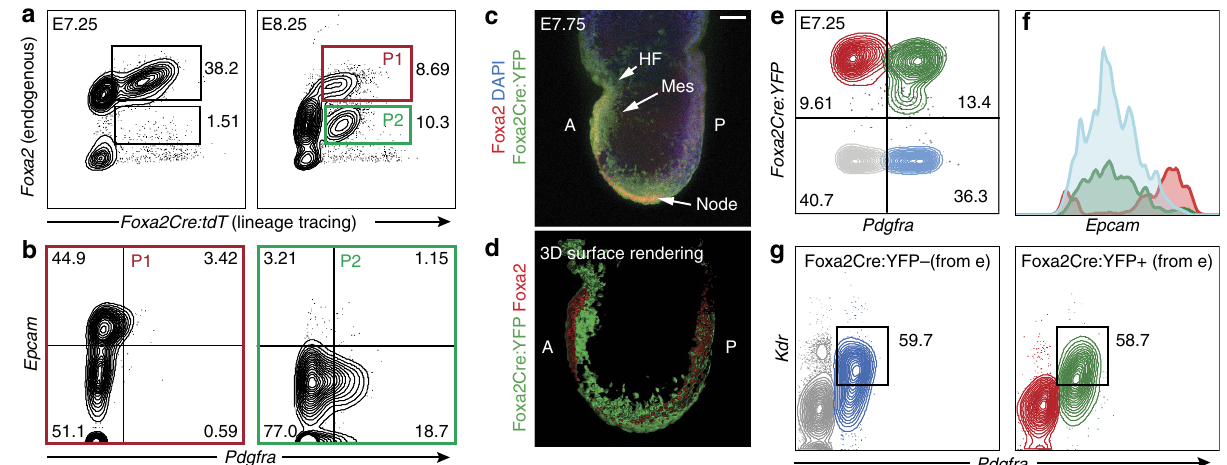
Figure 2 | Foxa2 expression marks a transient progenitor population during gastrulation that gives rise to CM. ( a ) Flow cytometry analysis of dissociated E7.25 (left) or E8.25 (right) Foxa2Cre:tdT embryos. Cells were stained with antibodies against endogenous Foxa2, which was compared with the Foxa2Cre:tdT lineage tracing marker. ( b ) Foxa2 þ tdT þ (P1, left panel) and Foxa2-tdT þ (P2, right panel) cells from E8.25 embryos were further analysed with antibodies against Epcam (endoderm) and Pdgfra (mesoderm). ( c ) Confocal z -projection of E7.75 Foxa2Cre:YFP embryo analysed by WMIF using antibodies against YFP and Foxa2. Scale bar, 75 m m. ( d ) Three-dimensional (3D) surface rendering of image shown in c generated using Imaris software. ( e – g ) Flow cytometry analysis of dissociated E7.25 Foxa2Cre:YFP embryos with antibodies against Pdgfra, Epcam and Kdr. Cells were first gated based